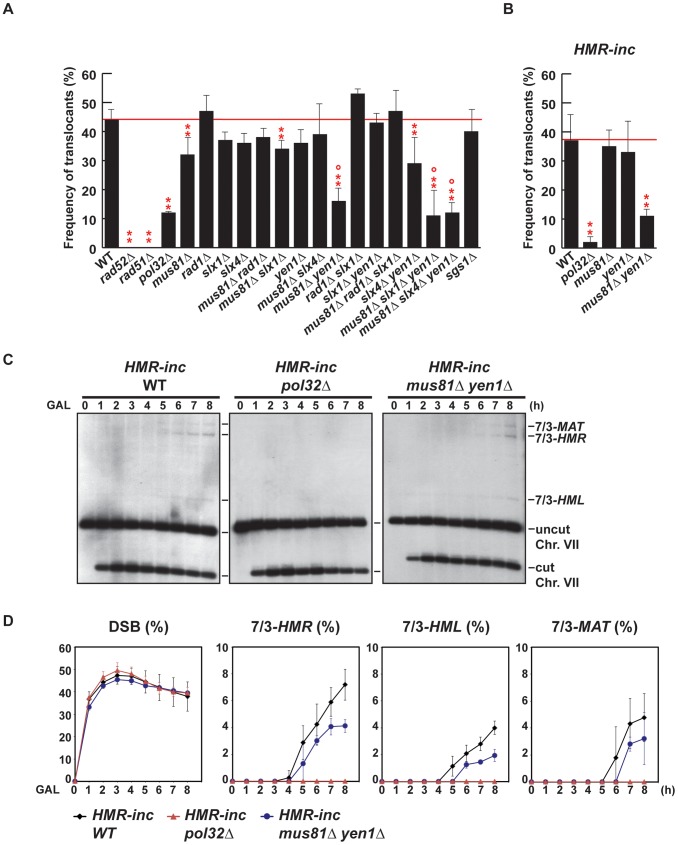
Genetic analysis of BIR intermediates processing in SSE mutants.(A) (B) Frequency of translocants of the different strains tested. See Material and Methods for details. ** and *, differences with the WT statistically significant (p<0.01 and p<0.05, respectively, χ2 with Yates' correction) °, statistically different from mus81Δ (p<0.01, χ2 with Yates' correction). Error bars represent standard deviations. (C) Appearance of BIR products as monitored by Southern analysis in HMR-inc WT, HMR-inc pol32Δ and HMR-inc mus81Δ yen1Δ strains. Experiments were performed as described in Figure 2C. A representative Southern analysis is shown for each genotype analyzed. Positions of the bands corresponding to 7/3-MAT, 7/3-HMR and 7/3-HML intermediates, and to the uncut and cut chromosome VII (Chr. VII) are indicated. GAL, galactose; h, hours. (D) Quantification of BIR product accumulation. Quantification results of chromosome VII cleavage (DSB), 7/3-HMR, 7/3-HML and 7/3-MAT BIR intermediates are shown as percentage. Mean values and standard deviations for 2–3 independent experiments are shown.